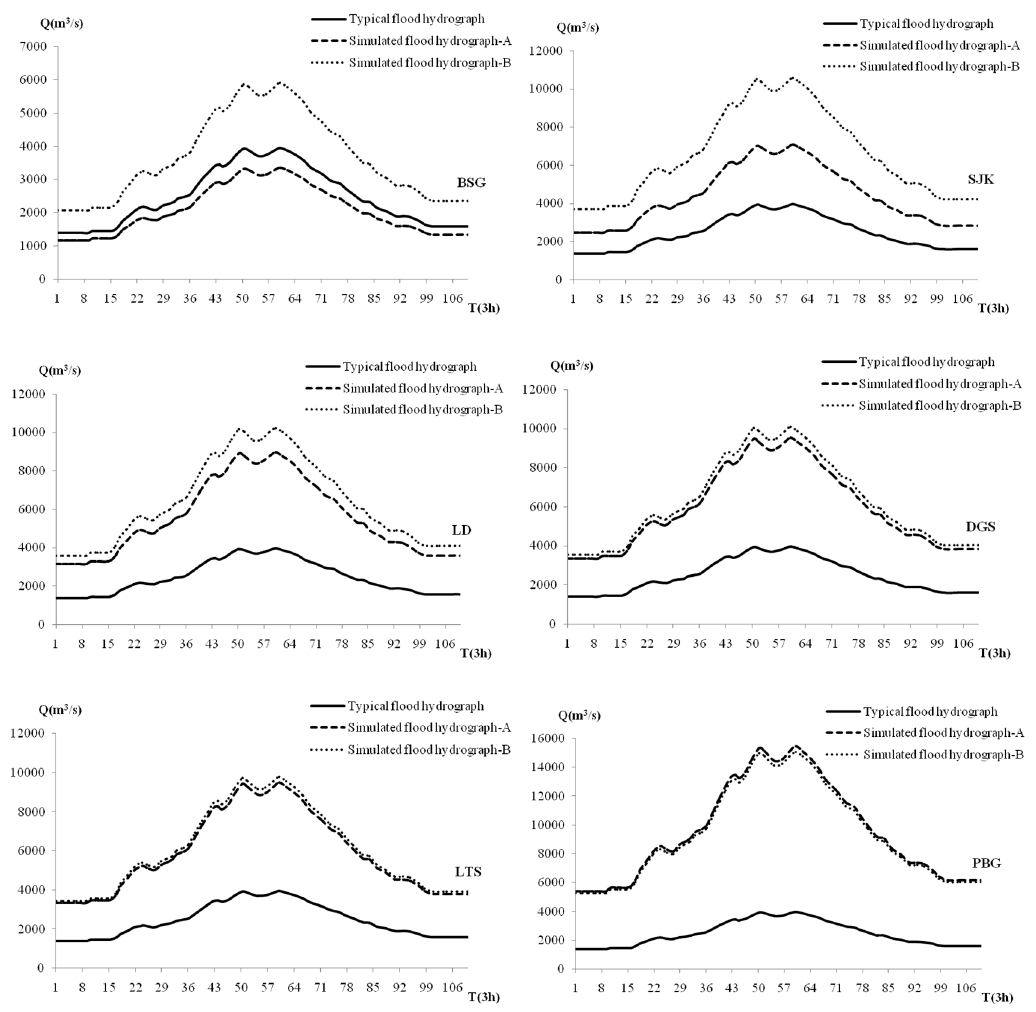
Figure 3. Typical and simulated flood hydrographs for Scenarios A and B. Table 9. PMFs, HWLs, and FZFs under Scenarios A and B.